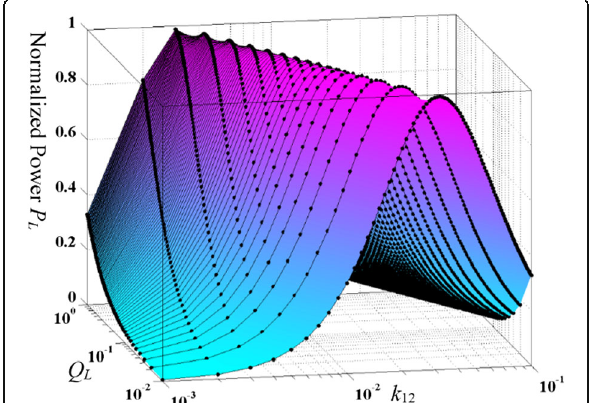
Fig. 4 Normalized active power P L as a function of k 12 and Q L . LEGEND: The abscissa axis is the coupling coefficient k 12 and the load quality factor Q L . They are two important parameters affecting the power. The normalized active power P L is displayed on the ordinate axis. It is a unimodal function of the coupling coefficient and the quality factor. Only when both of them get the appropriate value, can the power reach the